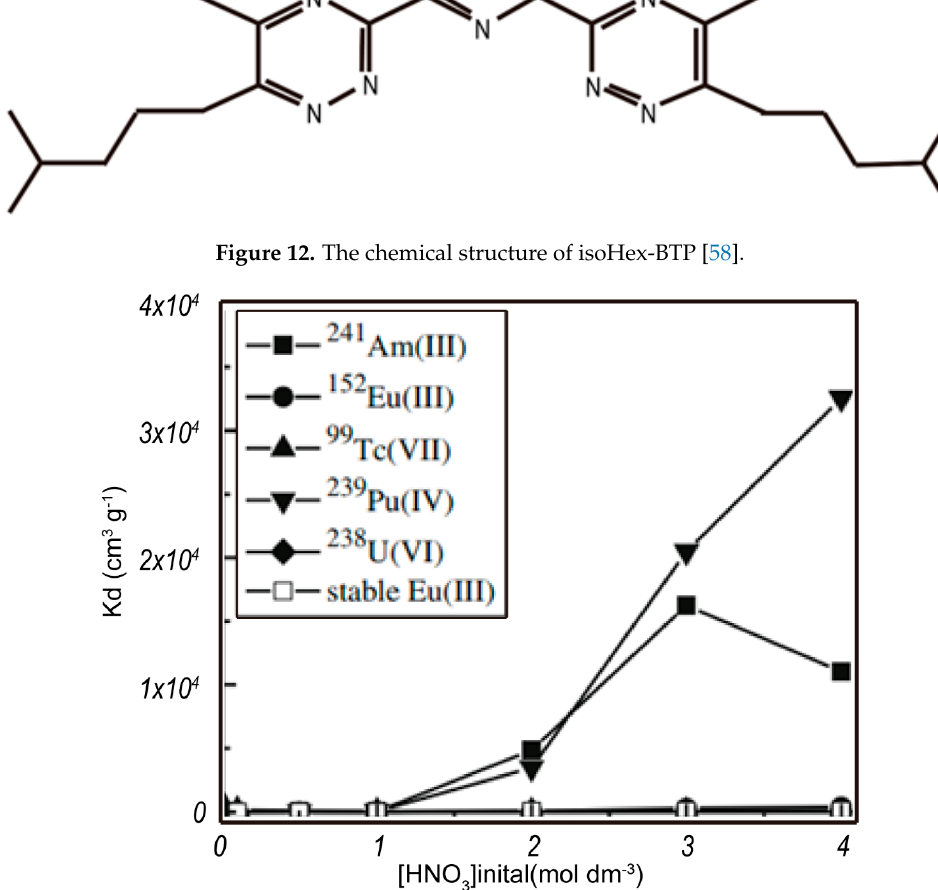
Figure 13. Effect of initial nitric acid concentration on the distribution coefficient of 241 Am(III), 239 Eu(III), 239 Pu(IV), 99 Tc (VII), 238 U(VI), and stable Eu(III) (298 K; phase ratio = 0.1 g; 5 cm − 1 , trace of 241 Am(III), 239 Eu(III), 239 Pu(IV), 99 Tc (VII), 238 U(VI), and stable Eu(III); 1 mmol dm − 3 ; sharking speed = 120 rpm; contact time = 24 h) [58].